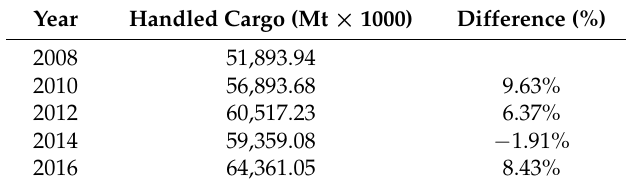
Table 3. Cargo handled at the Port of Valencia—Period 2008–2016. Source: Valencia Port Authority. Year